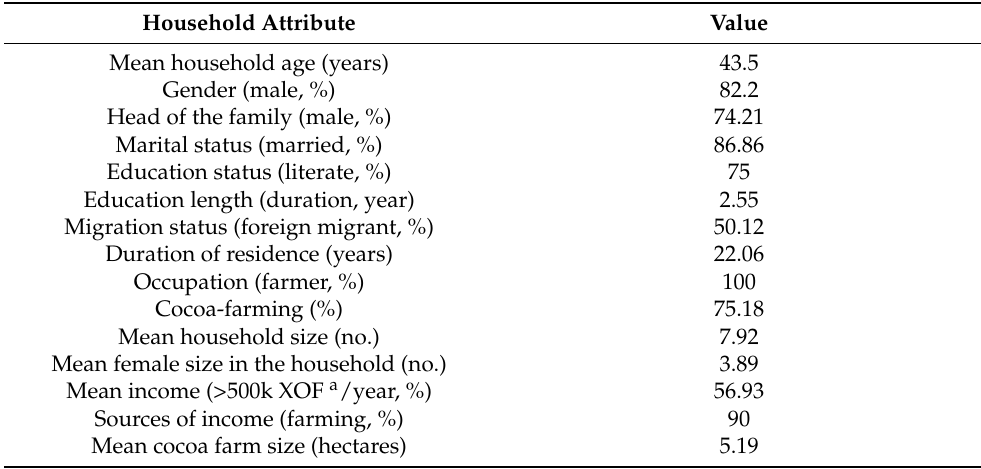
Table 5. Sampled household characteristics in the studied landscape (N = 411) in south-western C ô te